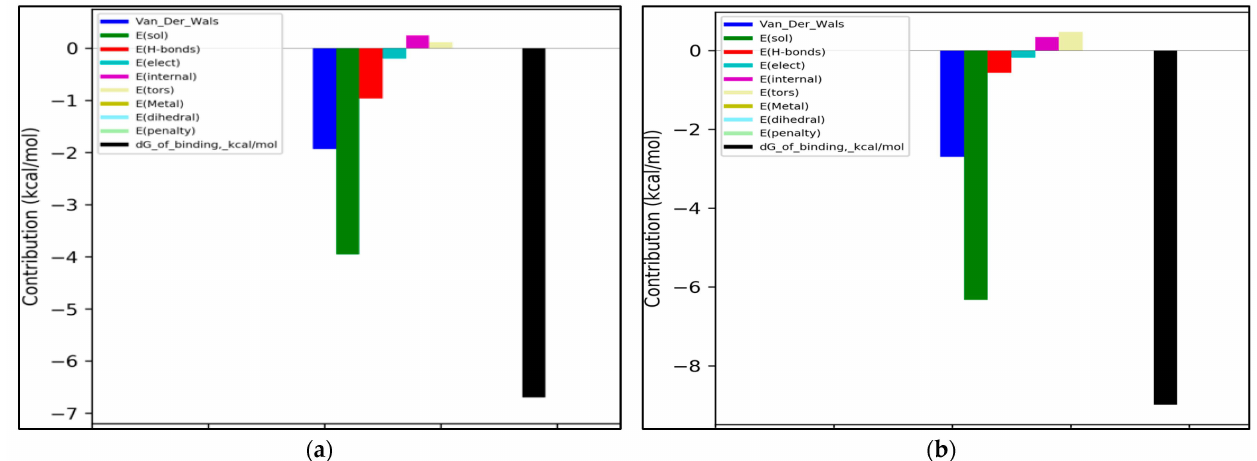
Figure 5. Energetic contributions (kcal/mol) to binding energy for ligand pairs’ docking: ( a ) lactucin in the presence of lactucopicrin (the priority for docking was established for lactucin); ( b ) lactucopicrin in the presence of lactucin (the priority for docking was established for lactucopicrin); Contributions (from left to right) depicted are: van der Waals interactions (navy blue), solvation energy (green), hydrogen bonds (red), hydrophobic interactions (light blue), repulsion (purple), energy of entropic losses associated with ligand’s rotatable bonds (yellow) and total predicted binding energy